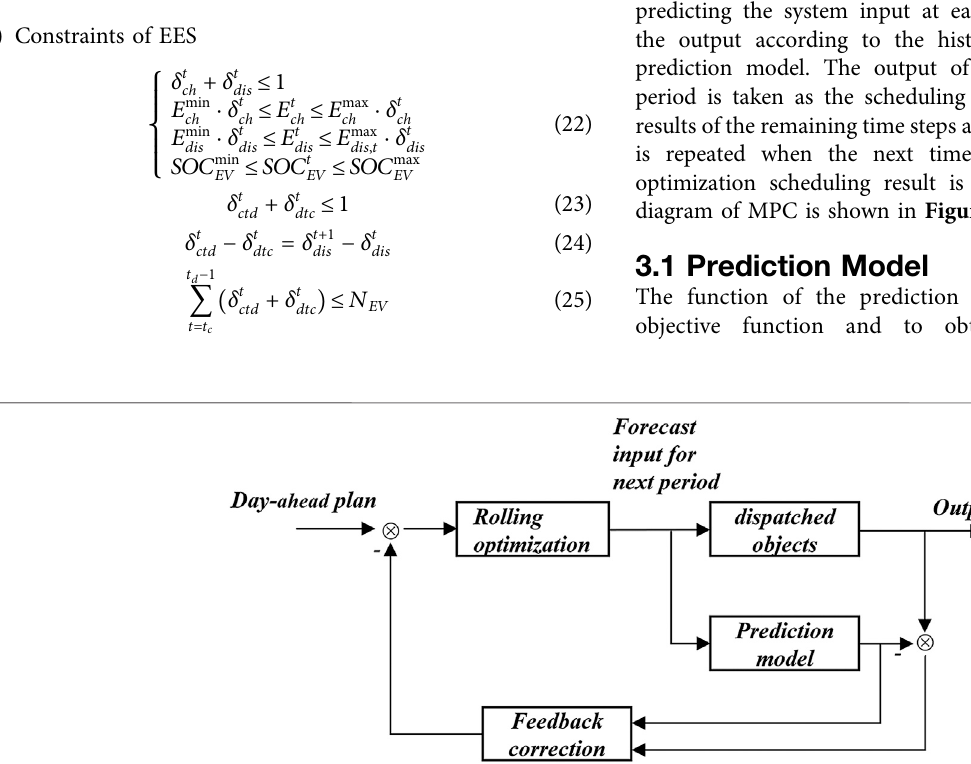
FIGURE 2 | Schematic diagram of